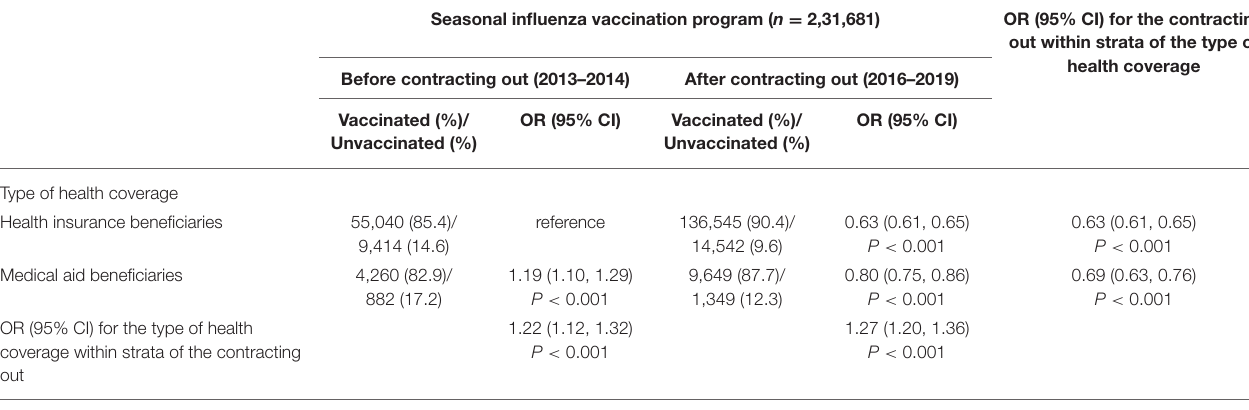
TABLE 4 | Contracting out program-stratified association of socioeconomic position with the unvaccinated rate for seasonal influenza among men. Seasonal influenza vaccination program ( n = 162,603) OR (95% CI) for the contracting Before contracting out